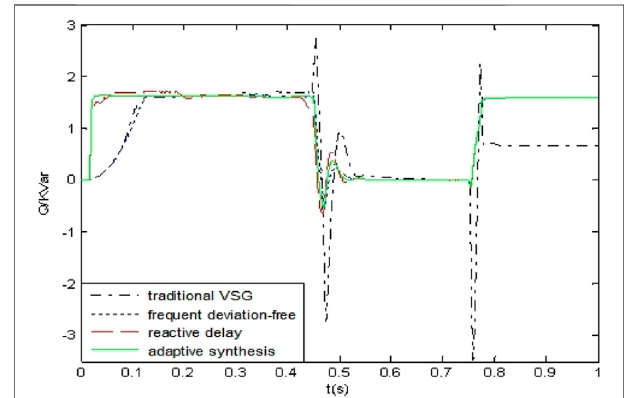
FIGURE 8 | Reactive power output of the microgrid.